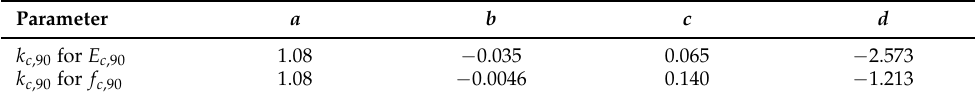
Table 10. Coefficients of regression curves shown in Figure 13 according to Equation (8) for k c ,90 for E c ,90 and k c ,90 for f c ,90 as a function of wall-to-floor thickness ratio, t w / t f .